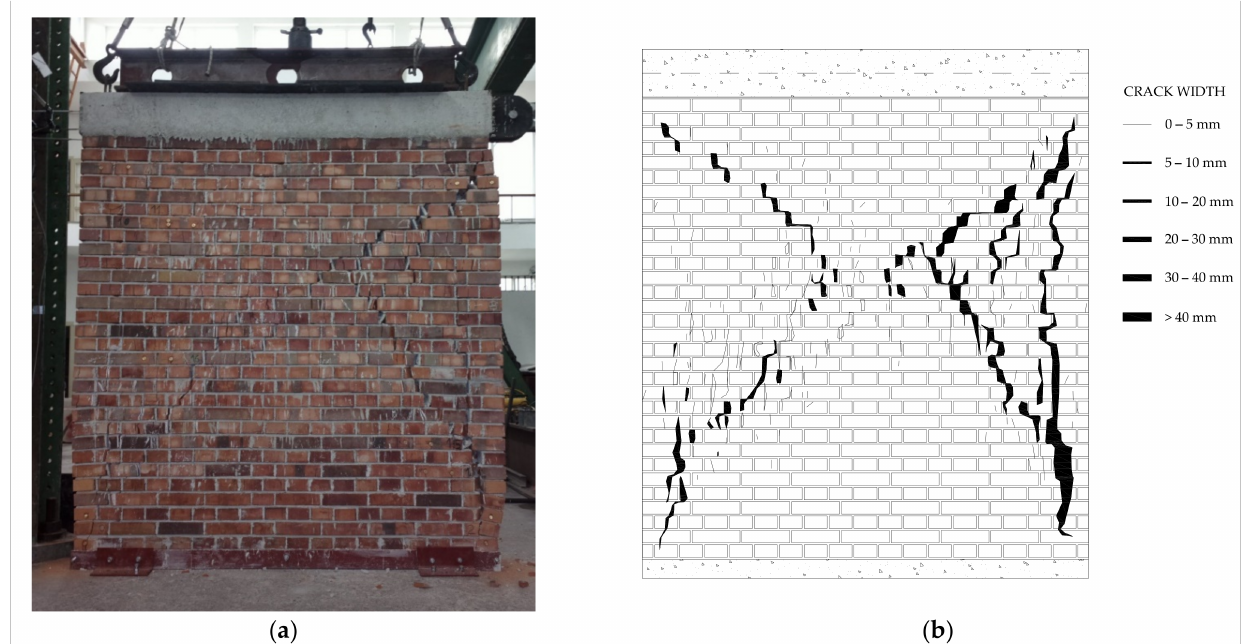
Figure 11. Wall W2 after testing: ( a ) photograph; ( b ) crack pattern and crack width. Experimentally obtained hysteretic loops are given in Figure 12 (W1) and Figure 13 (W2). Hysteretic curves of plain walls are generally symmetric and full, meaning that energy is dissipated through non-elastic deformations. The slope of the hysteretic curve decreases during unloading, which means that, besides the plastic behavior caused by friction, there are cracks that lead to a decrease of the initial stiffness (damage). A sharp vertical drop in force was registered during several load reversals. This was caused by the loss of contact between the bolt and the eyebar when the force changed direction (there was a gap of cca. 5 mm between the bolt and the hole). Additionally, the load reversal